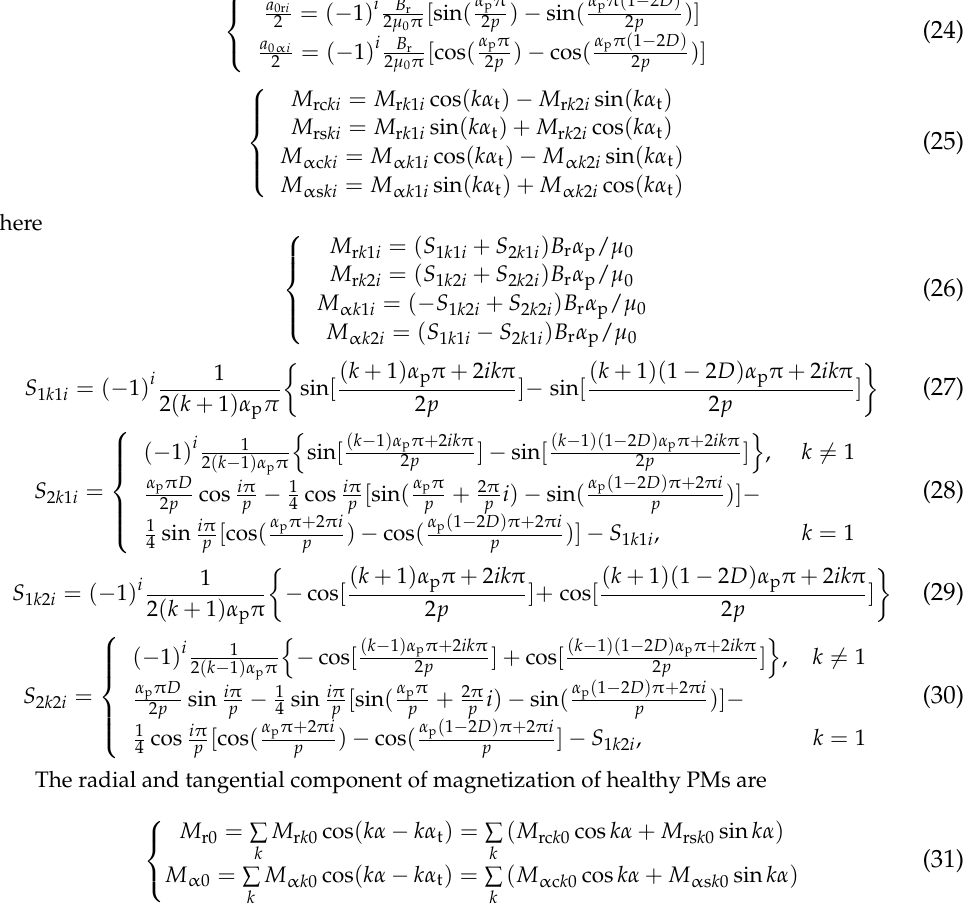
Figure 7. Magnetization of healthy PMs and partially demagnetized PMs (parallel magnetization). The magnetization of partially demagnetized PMs can be viewed as the superposi- tion of the magnetization of the healthy PMs and the effect produced by all the partially demagnetized PMs.